Question: In a single sentence, describe what this figure presents.
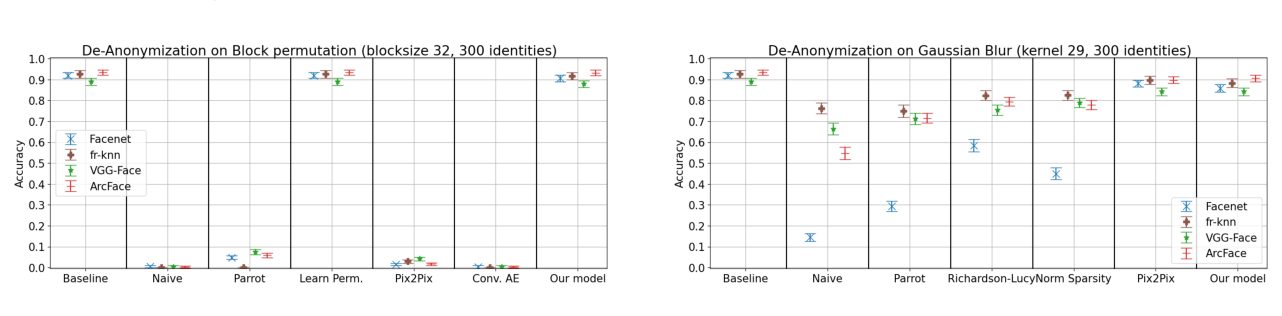
Answer: Recognition accuracy for Block Permutation (block- size 32), given for baseline, naive, parrot, de-anon. via learn permutation, via Pix2Pix, via Conv. AE (our model without linear layer), and via our model; on 300 identities of CelebA.